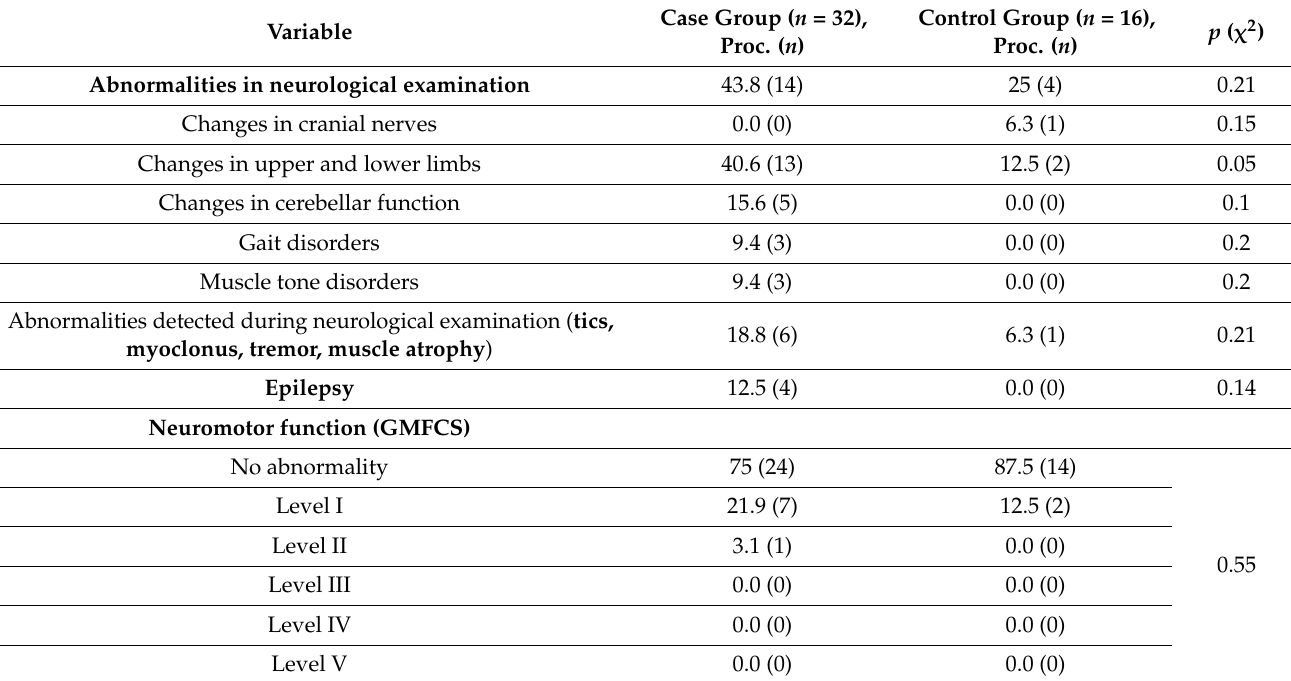
Table 3. Neurological examination, motor function, health-related quality-of-life, and cognitive assessments at an early school